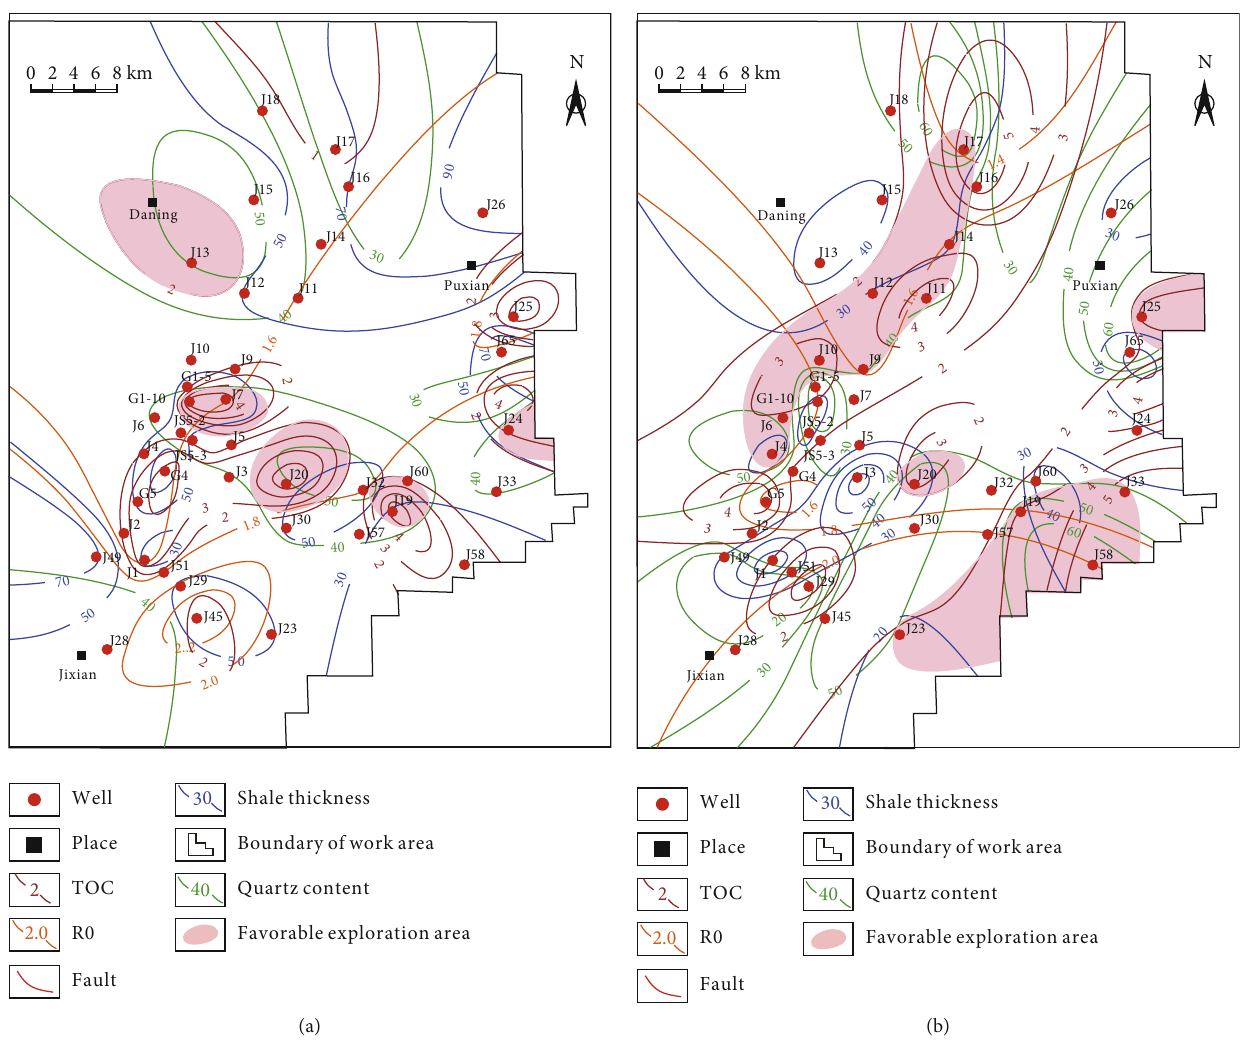
Figure 10: Prediction results of favorable areas for shale gas exploration in the lower Permian strata in the southeastern Ordos Basin. (a) Shanxi Formation; (b) Taiyuan